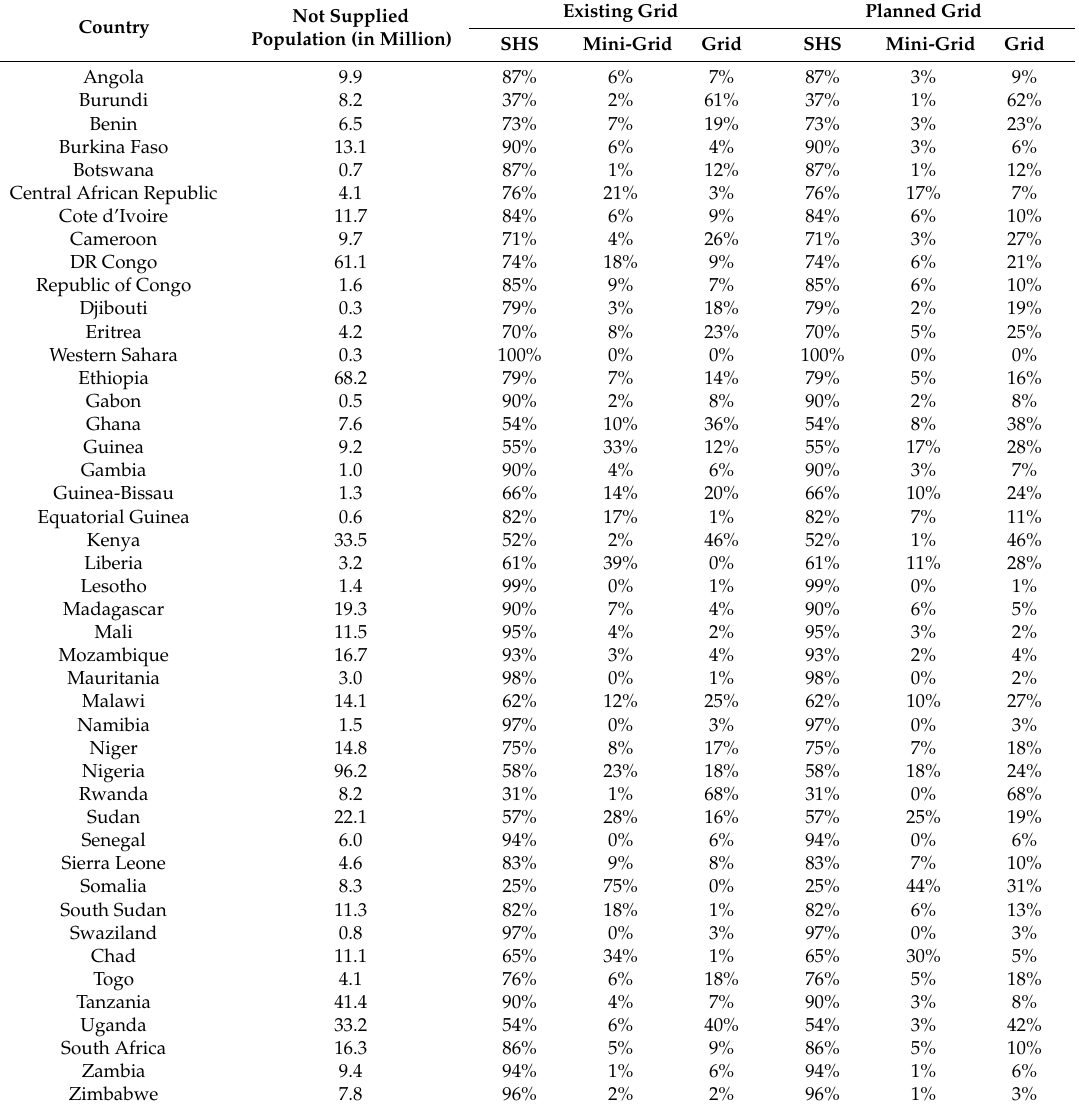
Table A4. Results on a country basis for SHS based scenario (including population density in the gird buffer